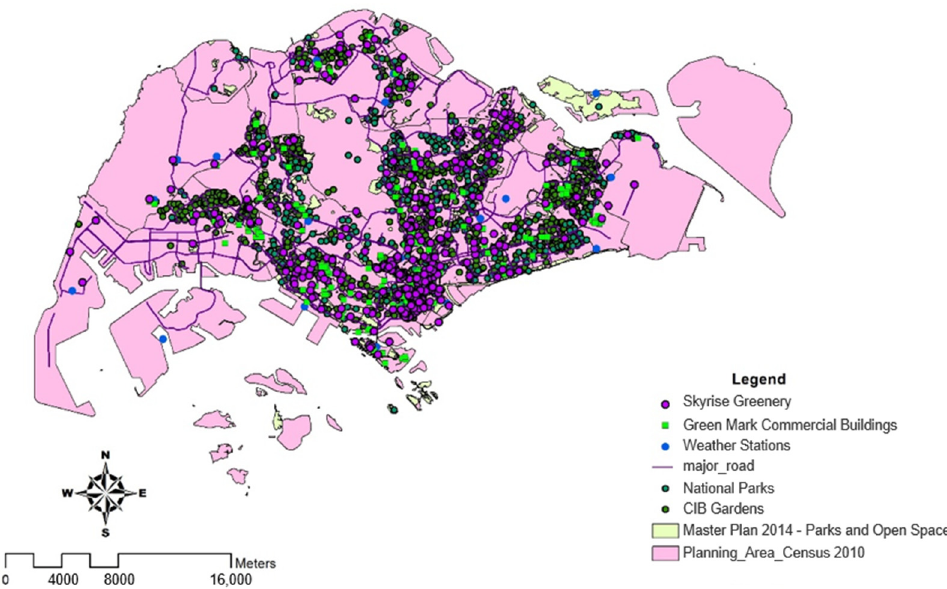
Figure 1. An overall illustration of Green Mark commercial buildings and facilities in Singapore. This map includes datasets of skyrise greeneries, Green Mark commercial buildings, weather stations, national parks (NParks) and Community in Bloom (CIB) gardens, parks and open spaces are displayed.